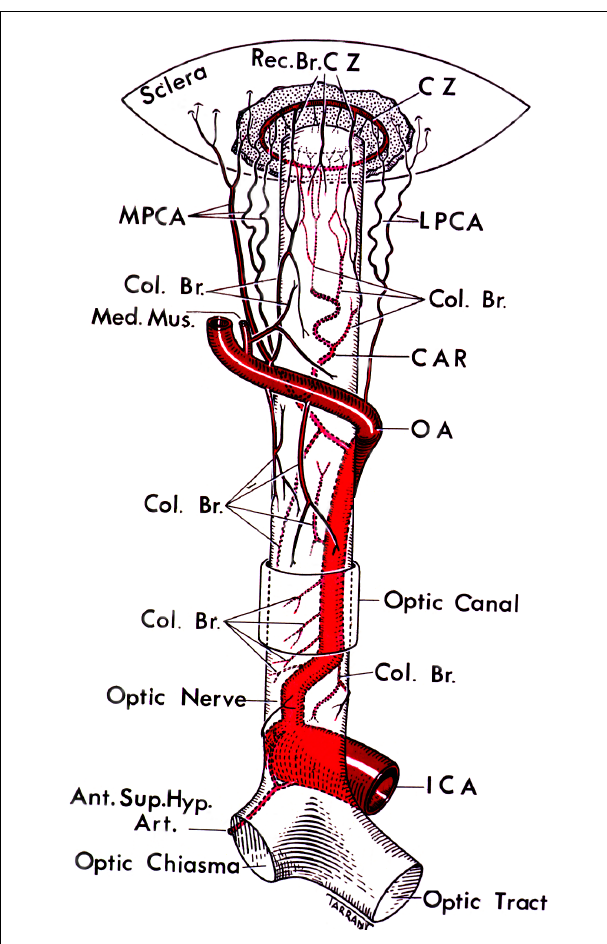
FIGURE 1 |The figure depicting the circle of Zinn-Haller and the blood supply to eye (Hayreh, 1963).